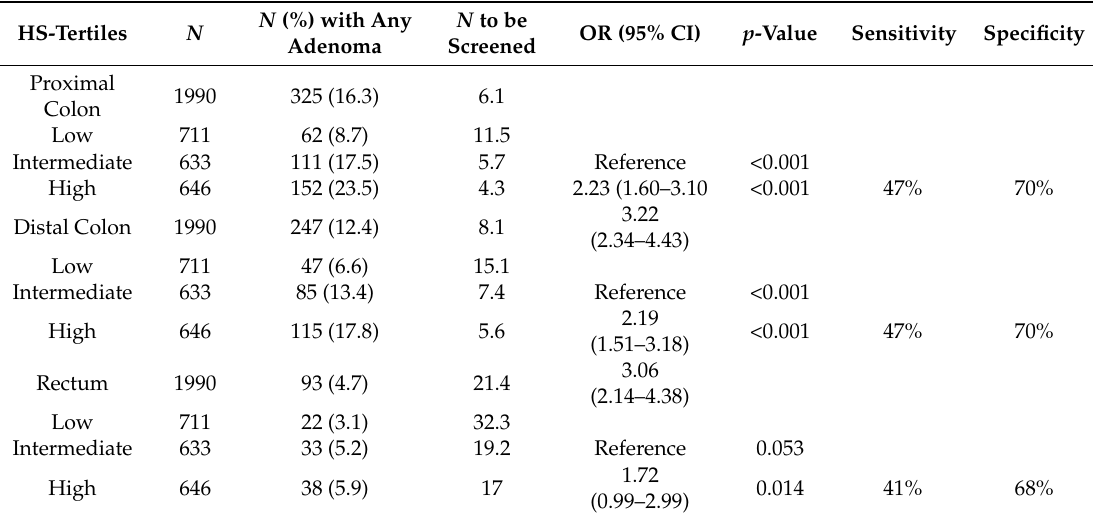
Table 6. Associations of the Heart Score (HS) Tertiles with colorectal lesion, by location.